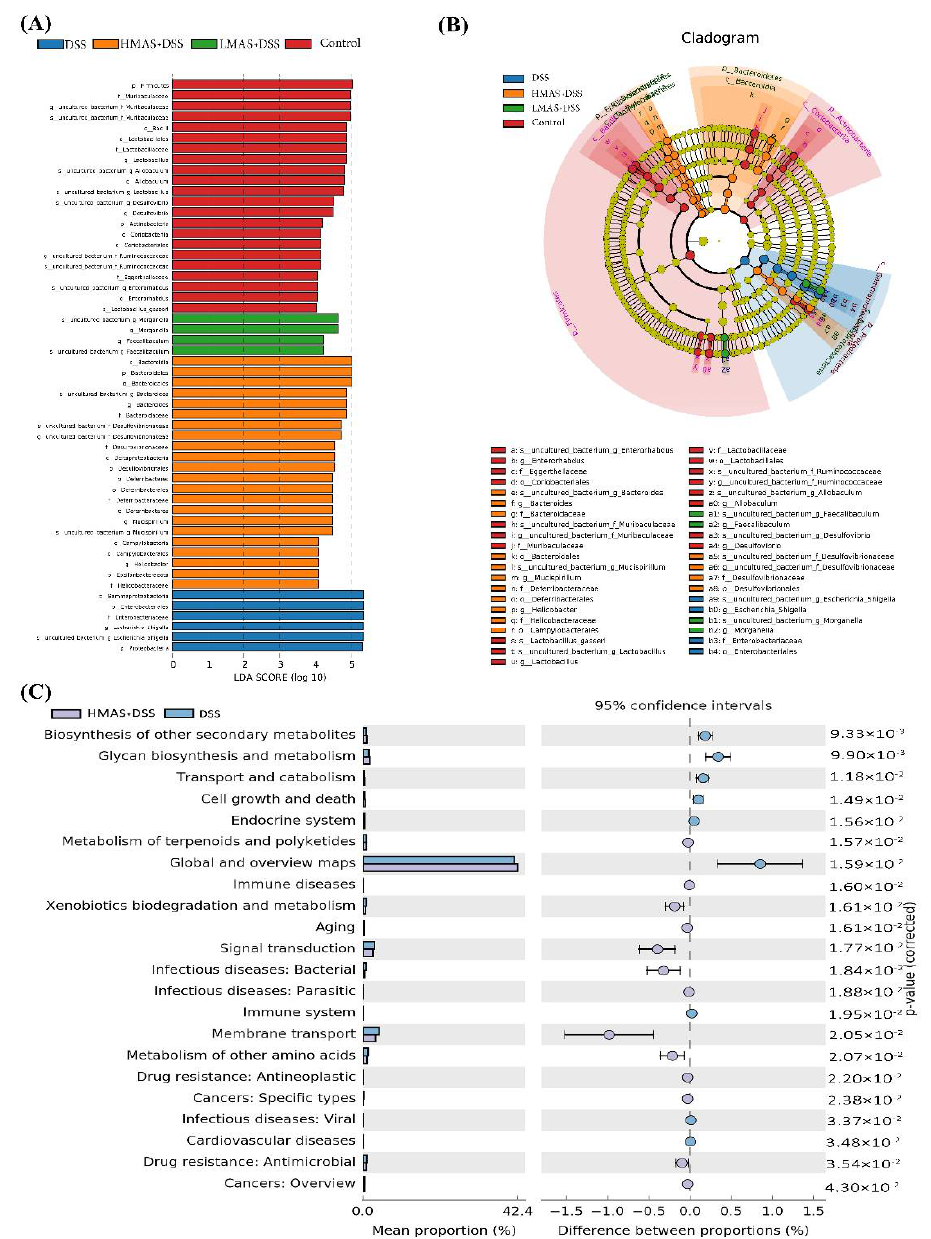
Figure 7. MAS regulates the bacterial metabolic pathway. ( A ) LDA analysis. ( B ) LEfSe analysis. ( C ) Analysis of differences in KEGG metabolic pathways between groups.